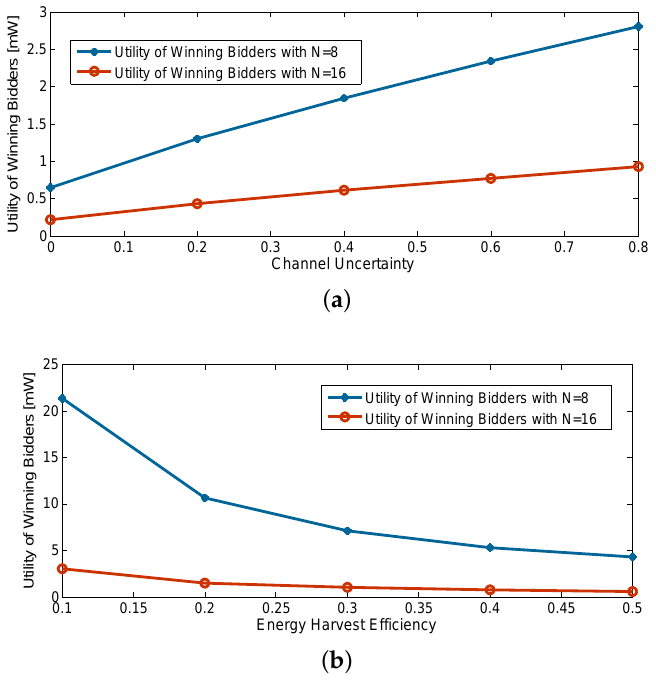
Figure 7. Impacts of channel uncertainty and energy harvest efficiency. ( a ) Utility of winning bidder vs. channel uncertainty; ( b ) utility of winning bidder vs. energy harvest